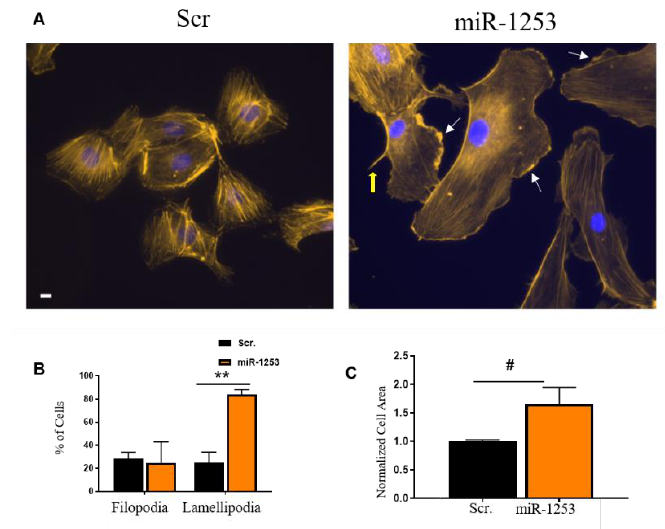
Figure 5. miR-1253 increased lamellipodia in HUVECs. ( A ) Representative pictures of HUVECs transfected with either scrambled control mimics (scr., left panel) or miR-1253 (right panel) and stained with rhodamine phalloidin for actin filaments and DAPI for nuclei visualization. White arrows indicate examples of scored lamellipodia and the thick yellow arrow indicates an example of scored filopodia. ( B ) Percent of cells visualized and counted for filopodia or lamellipodia in cells transfected with the scrambled or miR-1253 mimic versus total number of DAPI-stained cells ( n = 3). ( C ) Quantitation of cell surface area of HUVECs transfected with the scr. control or miR-1253 mimic. ** p < 0.01, # p = 0.09; two-tailed student’s T-test. Scale bar = 10 µ m. Columns represent the mean ± S.D. of three independent experiments and between a total of 28–89 (among scrambled conditions) and 25–46 cells counted (among mimic conditions) per